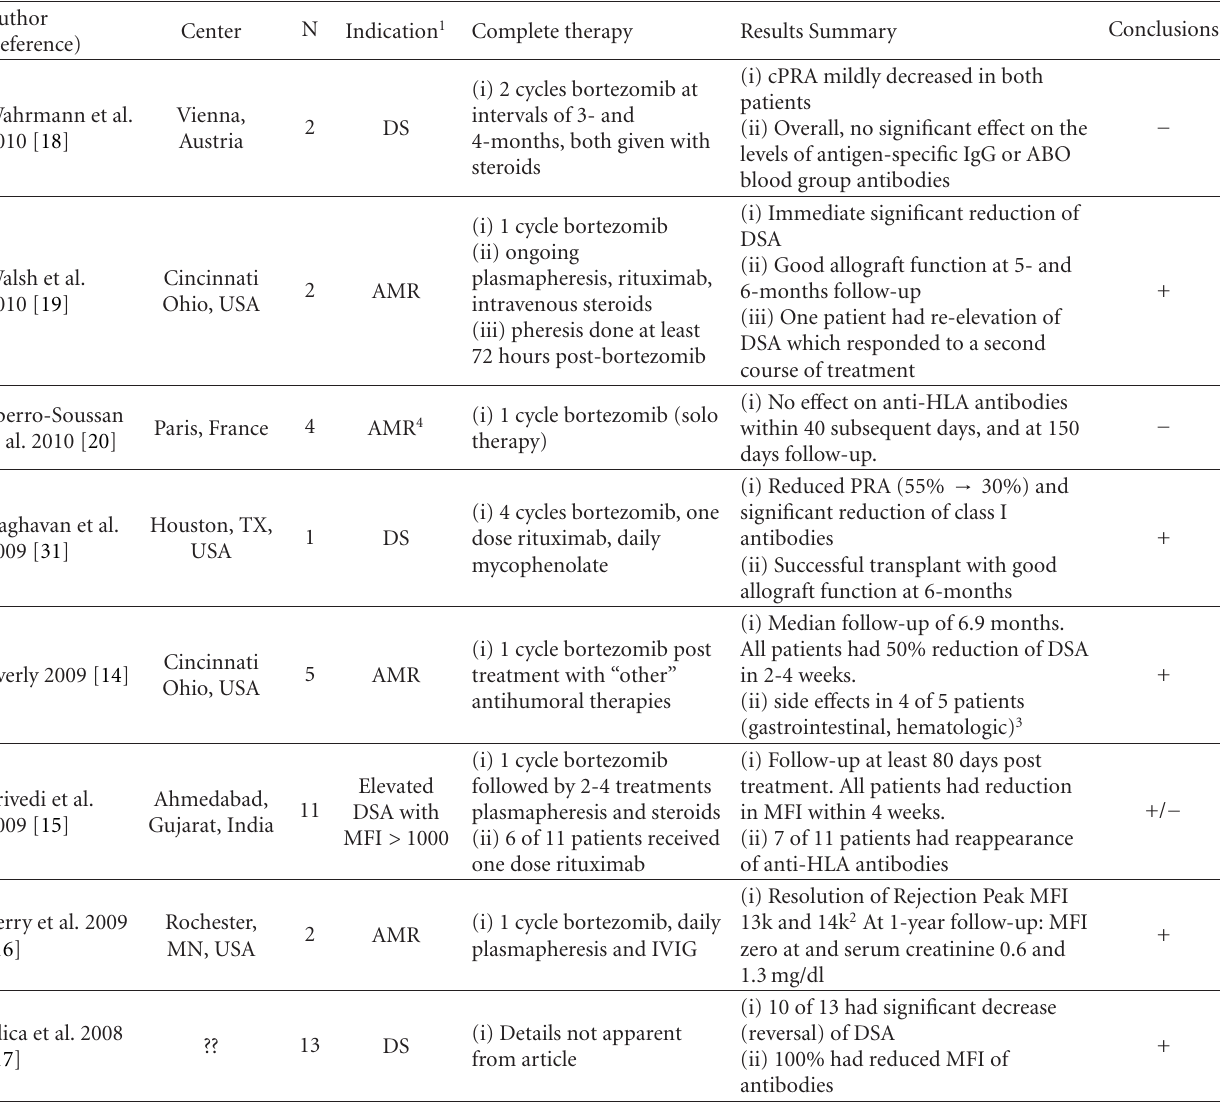
Table 1: Clinical characteristics and outcomes of published desensitization/rejection protocols using Bortezomib as combination or solo